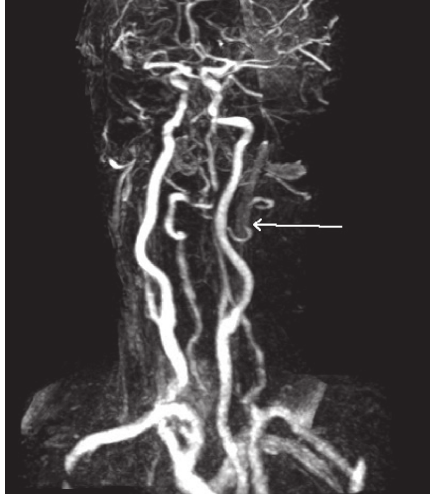
Figure 2: CTA showing left vertebral artery